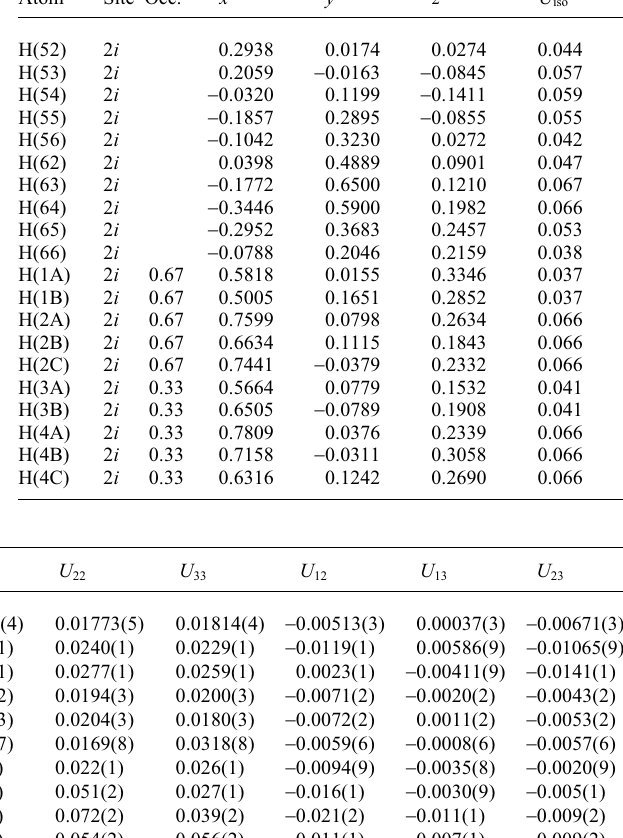
Table 2. Atomic coordinates and displacement parameters (in Å 2 ) . Atom Site Occ.